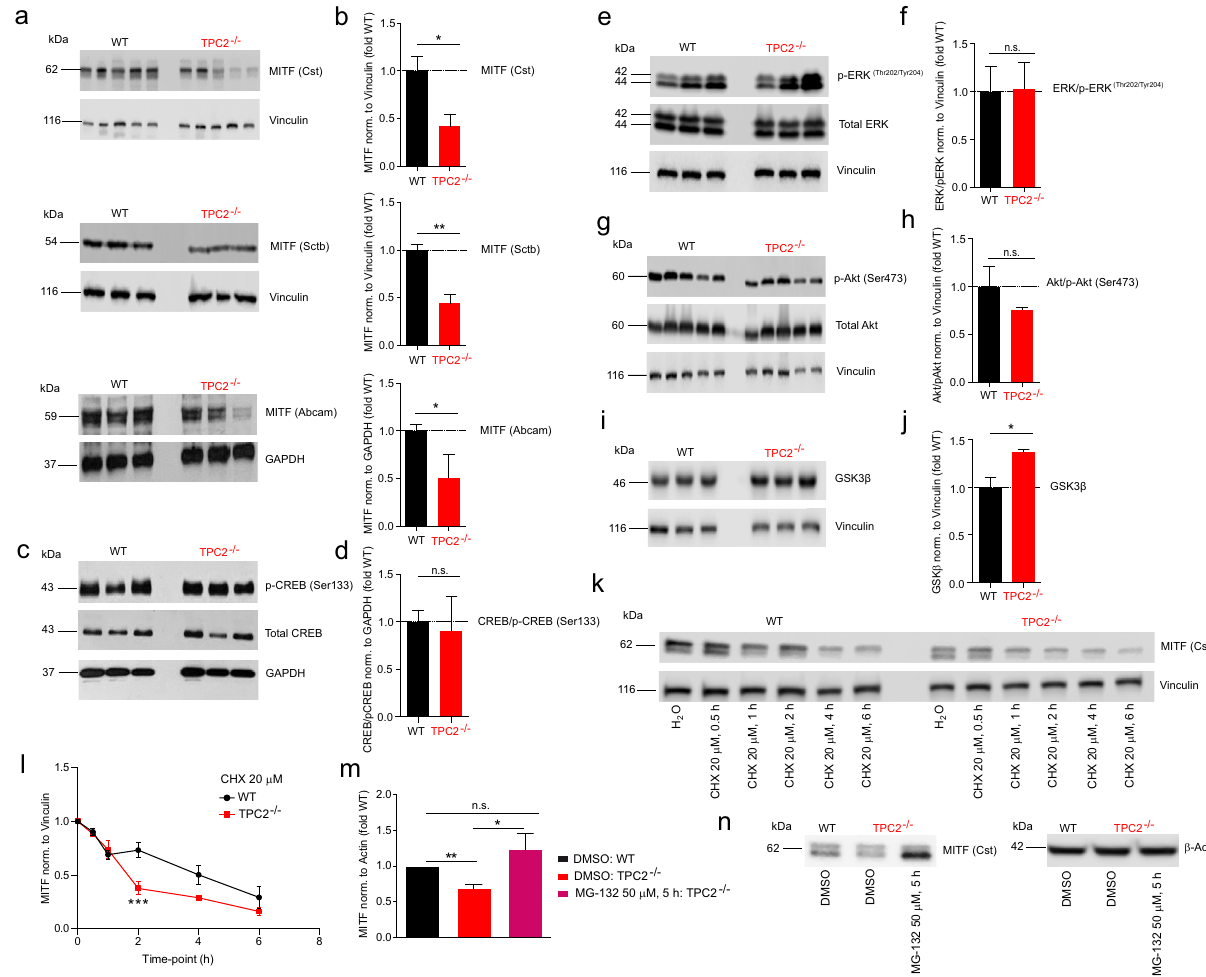
Figure 6. Effect of TPC2 knockout on MITF expression and expression of MITF regulator proteins using Western blot analysis and effect of protein synthesis and proteasome inhibition on MITF expression in WT and TPC2 −/− MNT-1 cells. Western blot experiments were performed with WT and TPC2 −/− MNT-1 cells as described in the Methods section. ( a ) and ( b ) WB experiments ( a ) and statistical analysis ( b ) showing MITF expression levels in WT and TPC2 −/− cells detected using three different anti-MITF antibodies (Cst = Cell Signaling Technology, Sctb = Santa Cruz Biotechnology). ( c – j ) WB experiments ( c , e , g , i ) and statistical analyses ( d , f , h , j ) showing expression levels of CREB/pCREB, ERK/pERK, Akt/pAkt and GSK3β in WT and TPC2 −/− cells detected using antibodies as described in the Methods section. Statistical significance was determined by Student’s t-test. Shown are mean values ± SEM, (n = 3, each). *P < 0.05, **P < 0.01. ( k – l ) WB experiments ( k ) and statistical analysis ( l ) showing the effect of cycloheximide (CHX) on MITF degradation in WT and TPC2 −/− MNT-1 cells. Statistical significance was determined by two-way ANOVA followed by Bonferroni multiple comparison test. Shown are mean values ± SEM, (n = 3, each). ***P < 0.001. ( m ) and ( n ) Rescue effect of the proteasome inhibitor MG-132 on MITF expression in TPC2 −/− MNT-1 cells. Statistical significance was determined by Student’s t-test. Shown are mean values ± SEM, (n = 3, each). *P < 0.05, **P <